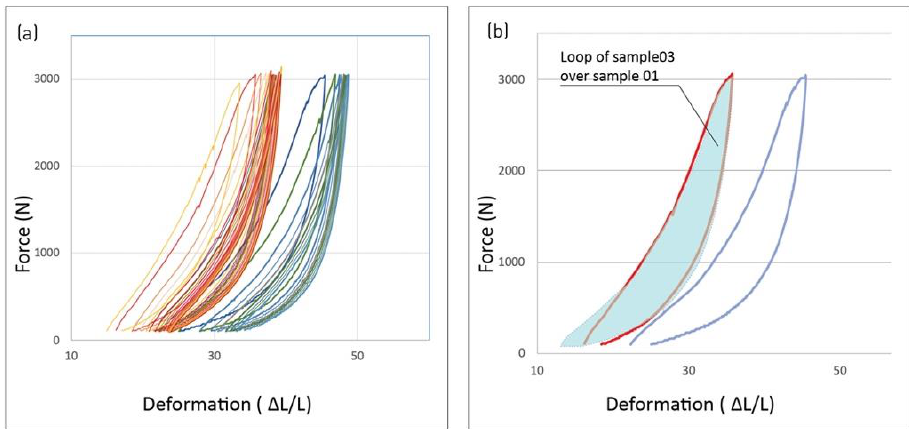
Figure 8. Similarity of loading–unloading loops between two samples of identical pleating pattern. ( a ) Repeated loading of sample 01 (red) and sample 03 (blue). ( b ) Comparison of loops between samples: enclosed area of sample 03 (blue stain) superimposed over loop curve of sample 01 (red).